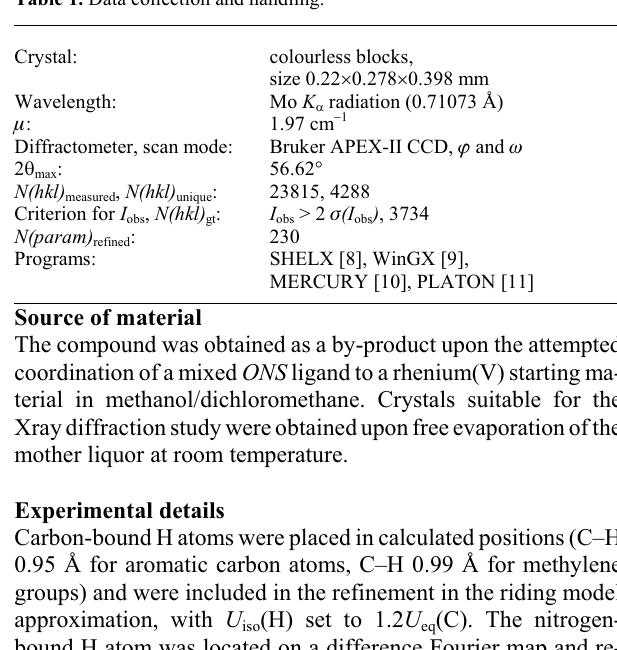
Table 1. Data collection and handling.